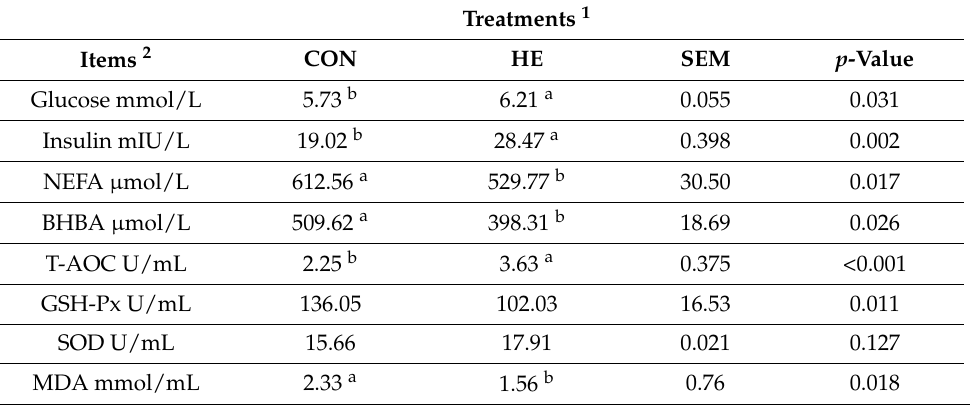
Table 2. Effect of dietary energy level during the transition period on the concentration of serum metabolites and the oxidative status in postpartum Angus cows.